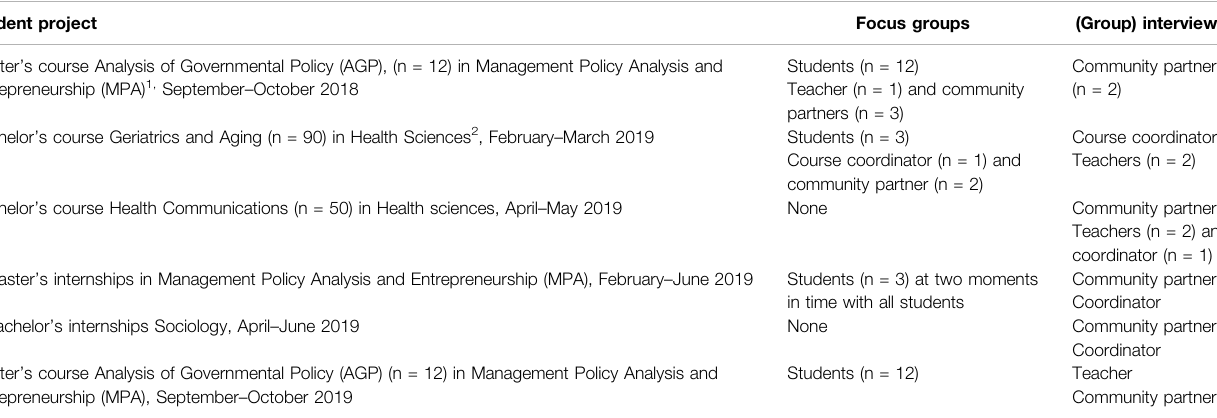
TABLE 1 | Interviews and focus groups linked to courses and